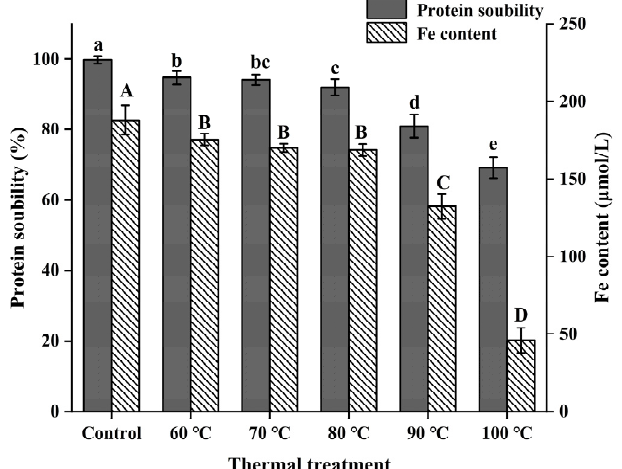
Figure 2. Effects of thermal treatment at different temperatures (untreated, 60, 70, 80, 90, and 100 ◦ C) for 10 min on the solubility and iron content. The differences between the protein concentration group and the iron content group are indicated by lowercase and uppercase letters, respectively ( p < 0.05). The error bars represent the standard error of the mean .